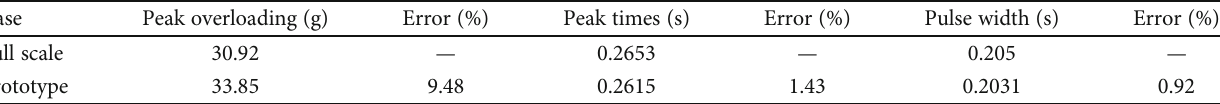
Table 4: Comparison of the overloading of the prototype and the full-scale system for the Mars Path fi